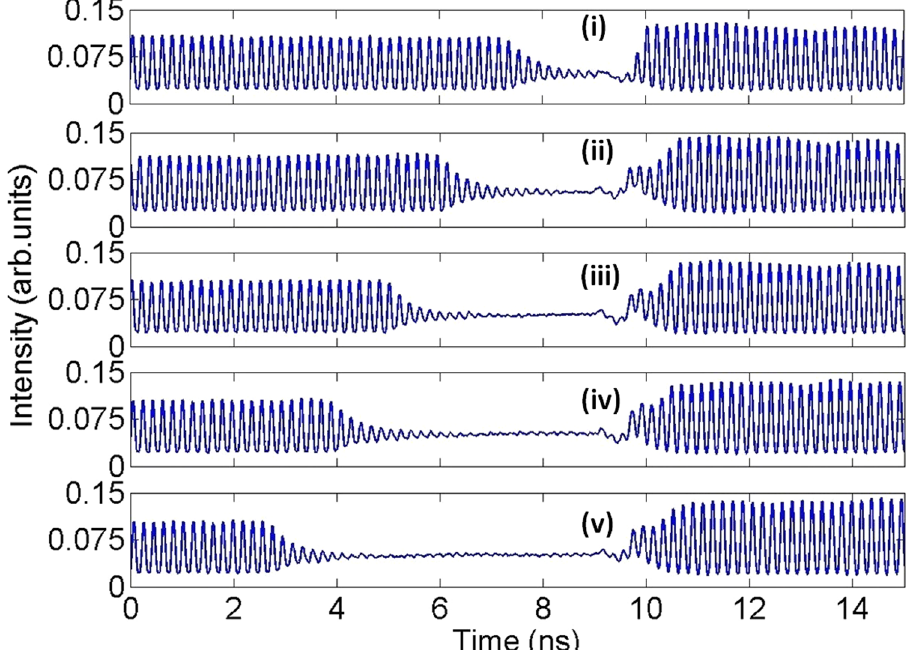
Figure 7. Measured time series at the output of the QDMLL when subject to the optical injection of an external signal with encoded ‘positive’ perturbations with K = 0.993 and varying t d : (i) 1.79 ns, (ii) 3.02 ns, (iii) 4.08 ns, (iv) 5.11 ns and (v) 6.36 ns. Controlled windows with tunable temporal length of inhibited picosecond optical pulsating regimes are obtained in each